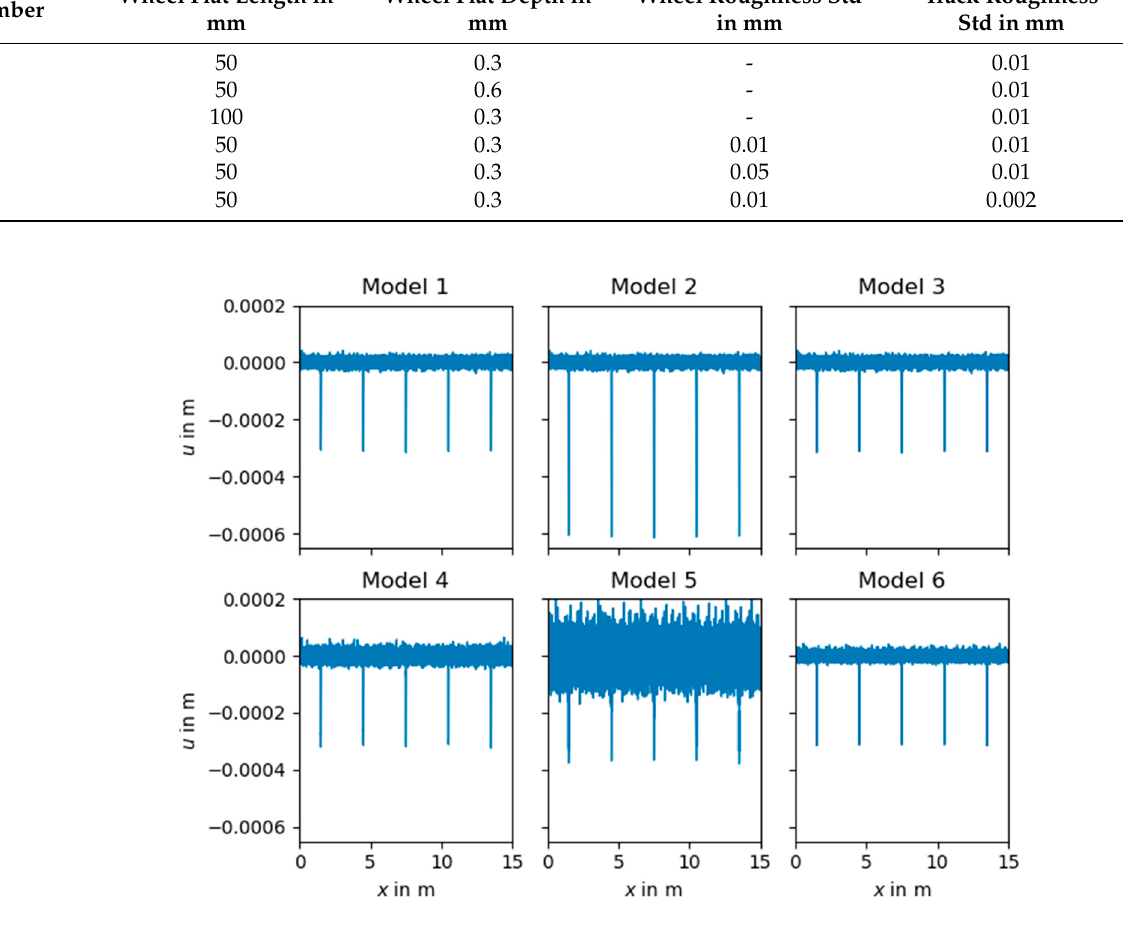
Figure 1. Different synthetic data models according to Table 1.